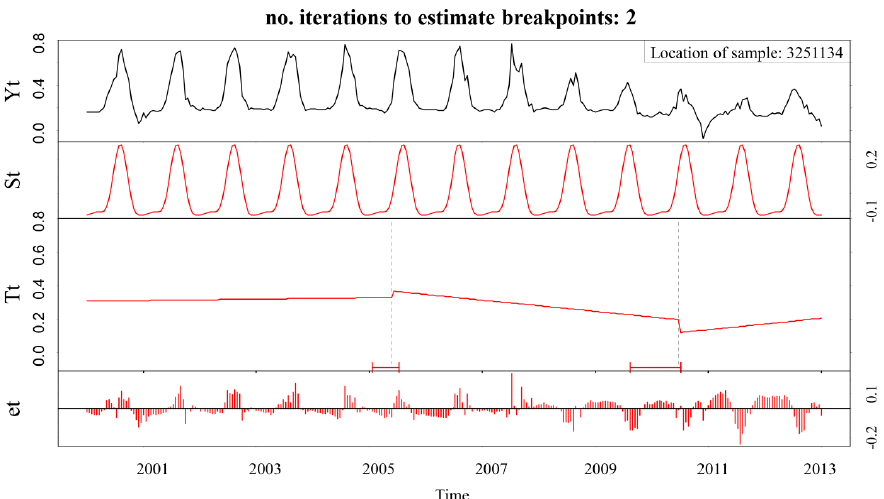
Figure 9. Change detection results of BFAST using the full time series of typical sample (No. 3251134), Yt is the full time series of NDVI, St is the seasonal component, Tt is the trend component, and the et is the residuals component. Minimum interval of two years of data ( i.e. , 46 observations) between successive change detections, other parameters in BFAST model such as max.iter, season, level, and type were set as 10, harmonic, 0.05, OLS-MOSUM, respectively.